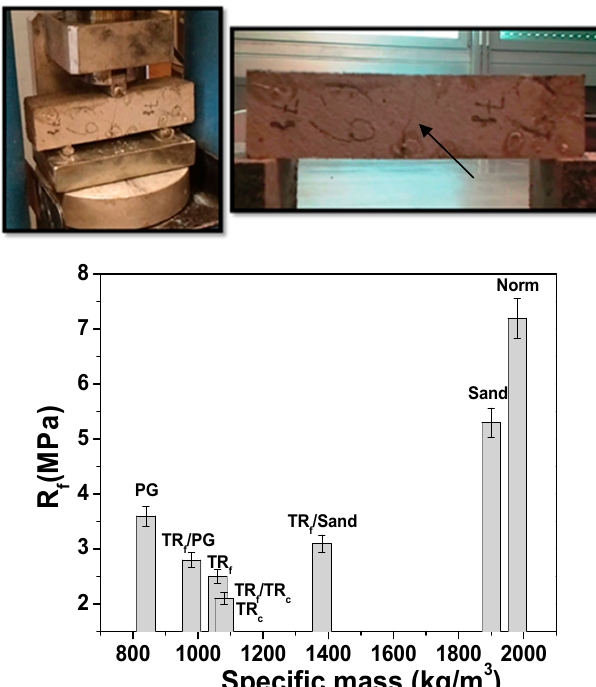
Figure 3. Flexural strengths of the cement mortars. On the top: discrete cracks after rupture in the TR specimens (evidenced by the arrow), with the two parts of the sample still connected by the tyre rubber.